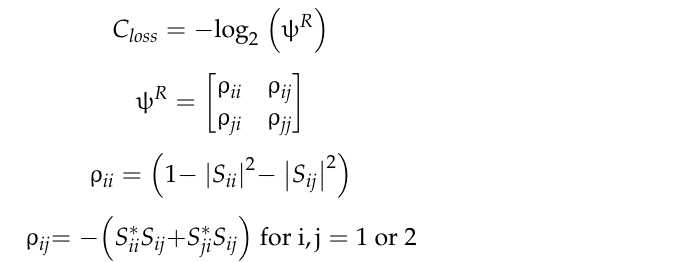
a communication channel without data loss. The values of CCL can be calculated by